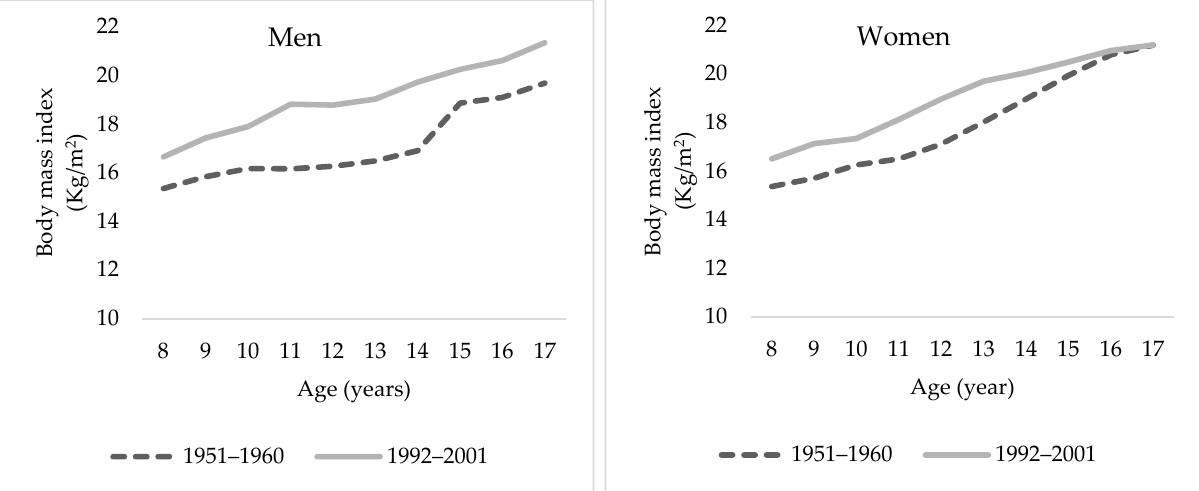
Figure 5. Median BMI evolution between children aged 8–17 years by sex. Sources: Authors’ calculations based on Luna–Jaspe et al.[2] and Durán et al. [36]